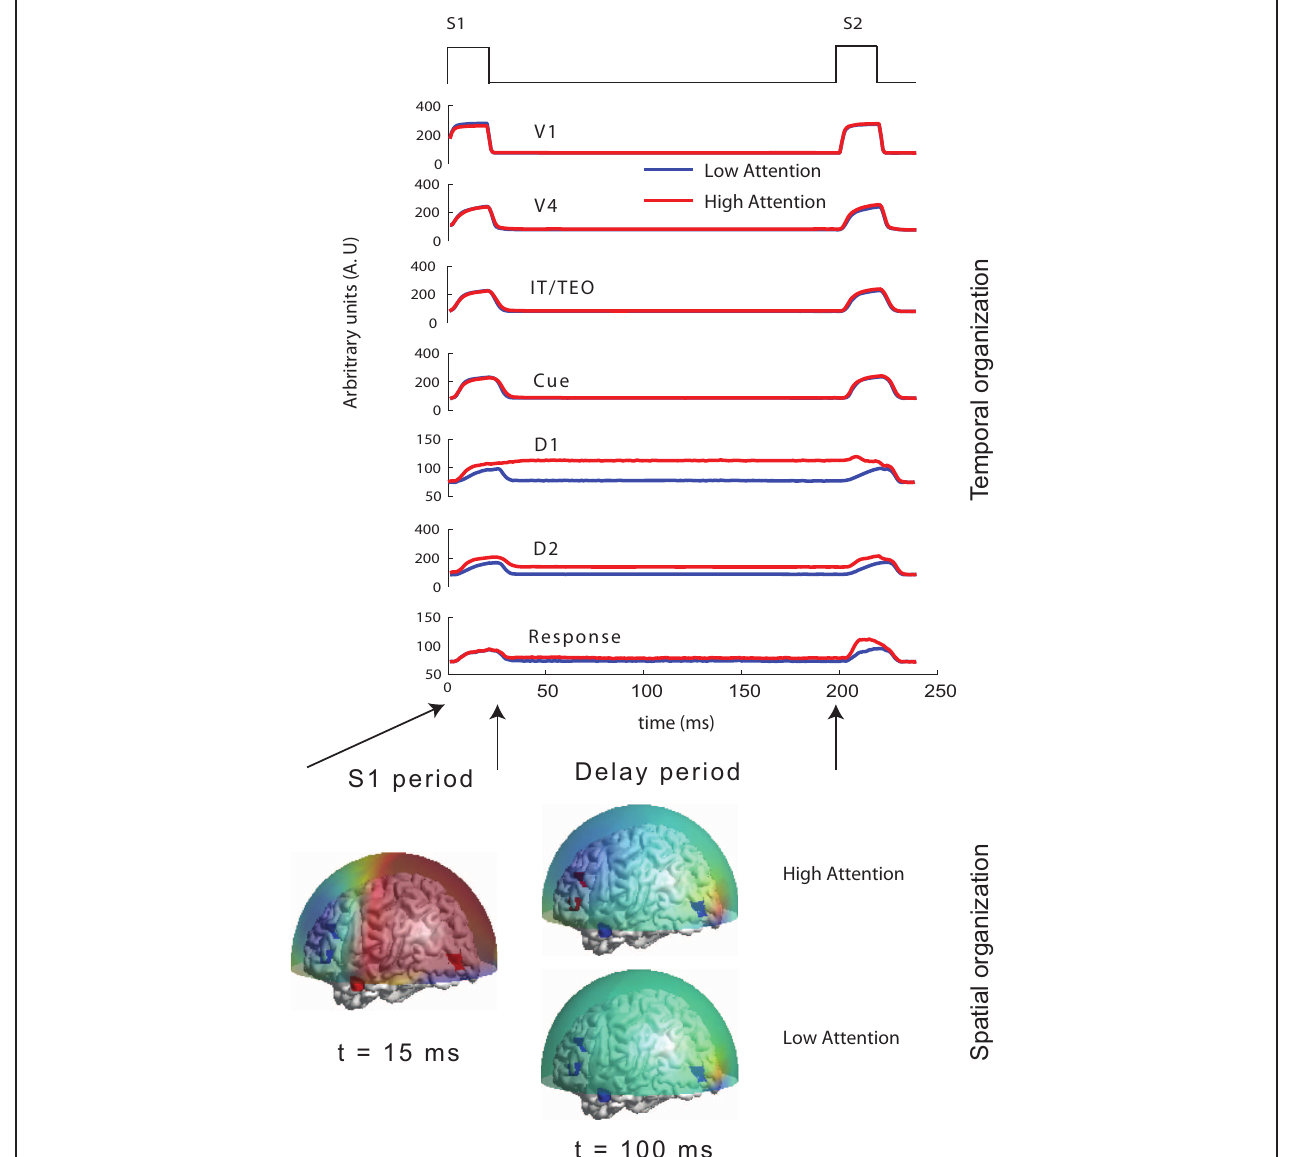
sensors using a forward solution with spherical head model. Topographic maps of this activity are plotted over a transparent hemisphere at times t = 15 (within initial S1) and t = 100 (during delay). During S1 similar identical network organization between passive viewing (low attention) and DMS task performance (high attention) occurs. However, network organization changes during the delay period. Discerning by looking at raw topographic maps is quite hard, as illustrated by closeness of the scalp topography between the two task conditions during delay period. The temporal microstructure of cortical network (TMCN) analysis retrieves the onset of recruitment of the task-specific prefrontal networks at the sensor